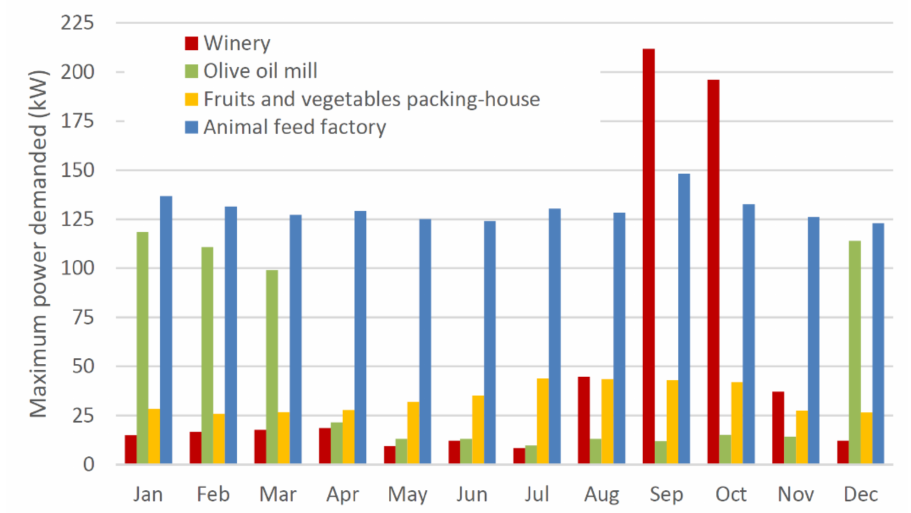
Figure 4. Maximum monthly power demanded in the industries